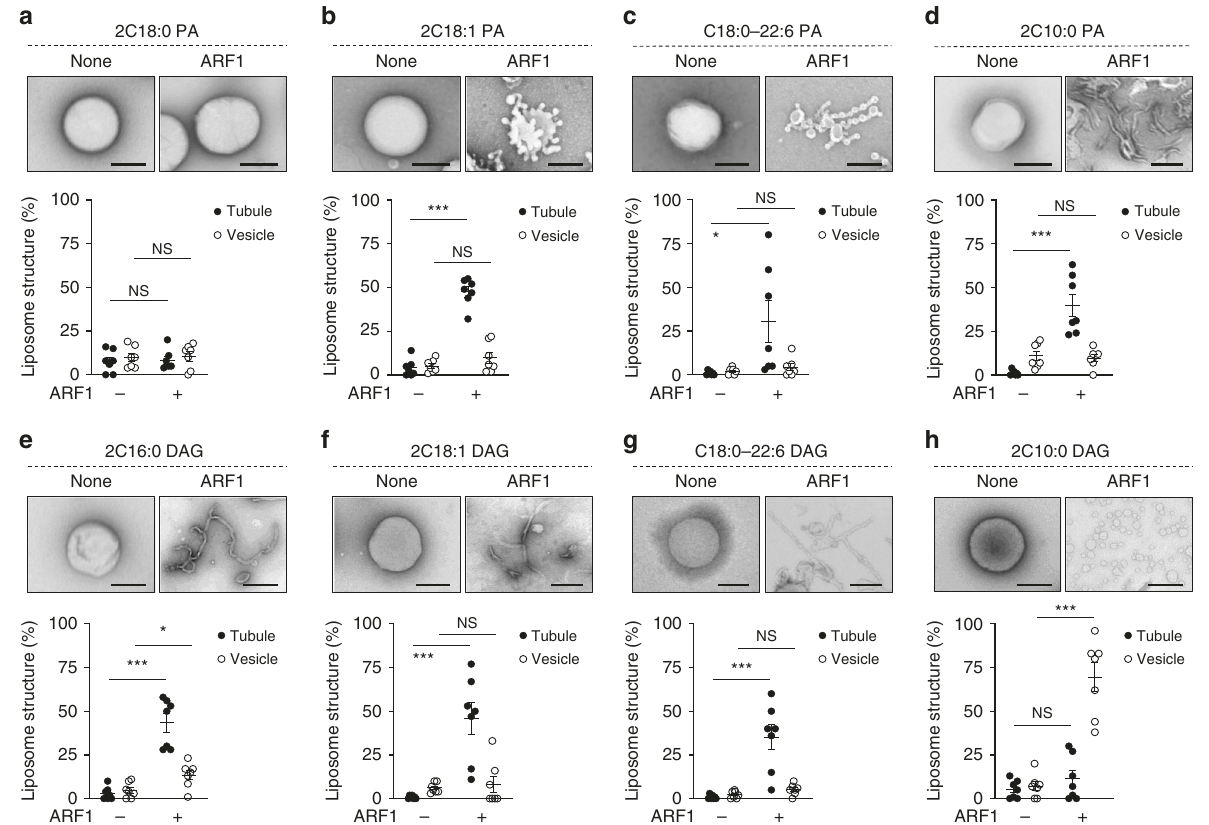
Fig. 7 Short diacylglycerol (DAG) promotes vesiculation by ADP-ribosylation factor 1 (ARF1). Quantitative data are shown as mean ± s.e.m. Signi fi cance was tested using the two-tailed Student ’ s t test, * P < 0.05, *** P < 0.0001, NS P > 0.05. a – d Liposomes with different forms of phosphatidic acid as indicated were incubated with recombinant ARF1 and then examined by electron microscopy (EM). Representative images are shown above, bar = 250 nm. Quantitation of liposome tubulation and vesiculation is shown below; n = 4 independent experiments. e – h Liposomes with different forms of DAG as indicated were incubated with recombinant ARF1 and then examined by EM. Representative images are shown above, bar = 250 nm. Quantitation of liposome tubulation and vesiculation is shown below; n = 4 independent experiments. Source data are provided as a Source Data fi